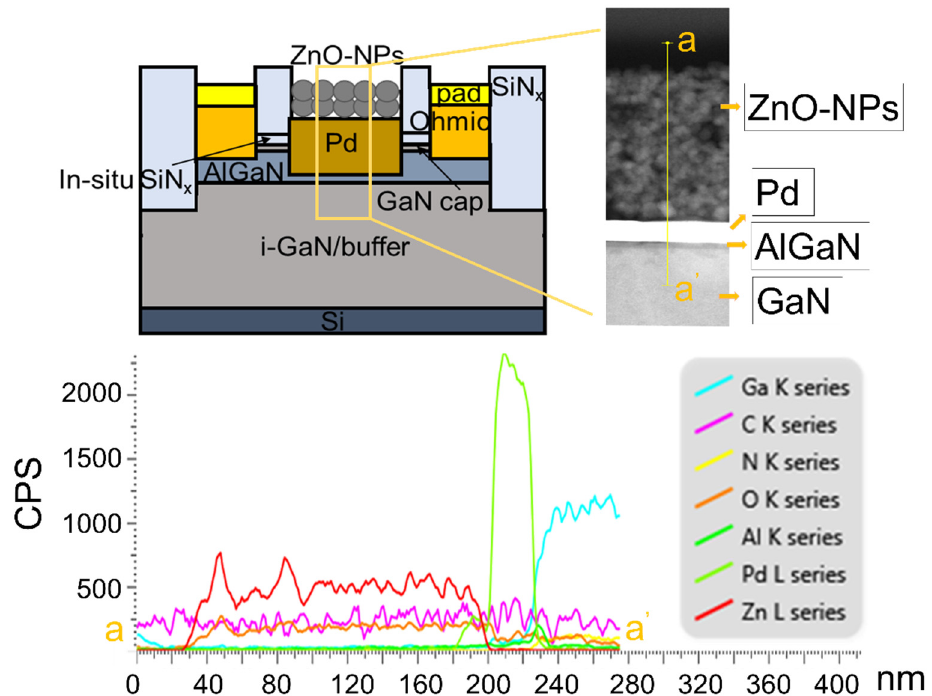
Figure 5. Cross-sectional schematic of AlGaN/GaN based hydrogen sensor with a dual catalyst layer. The inset shows the cross-sectional TEM image of the dual catalyst layer of ZnO-NP/Pd. Sensor characteristics were measured at room temperature with and without UV illumination, where the UV light source was a 280 nm LED operated by a driving current of 180 mA resulting in an optical power density of 1.82 W/cm 2 at the catalyst surface. The hydrogen concentration used for the tests was 4%.